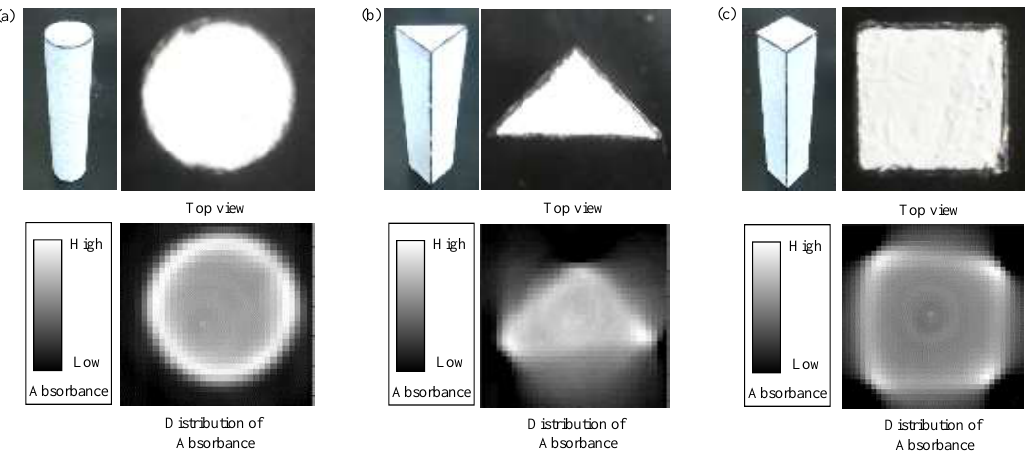
Figure 5. The experimental result of obtaining outlines of wooden objects. ( a ) A cylindrical column and ( b ) a triangular prism and ( c ) a quadrangular prism.